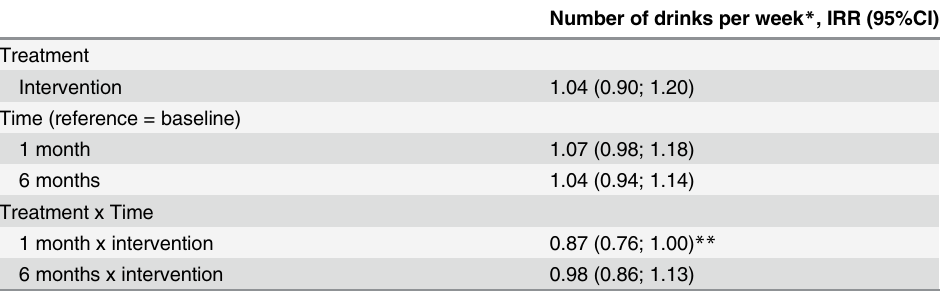
Table 2. Regression model for number of drinks per week, baseline to 6 months (n =